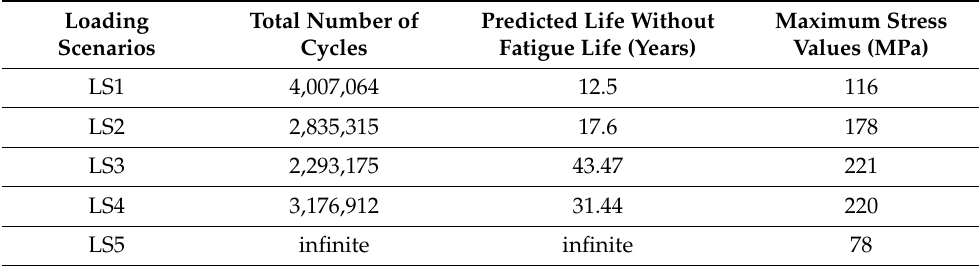
Table 15. Loading scenarios summary